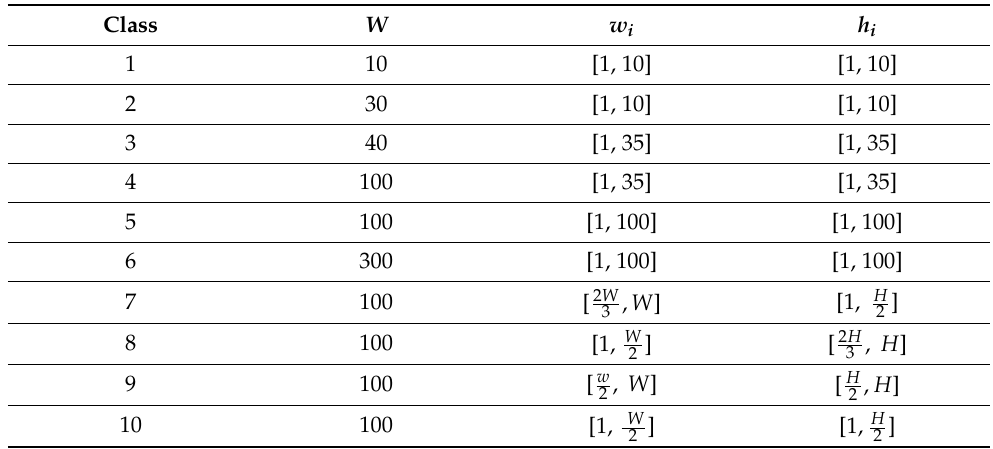
Table 4. Data parameters of Set